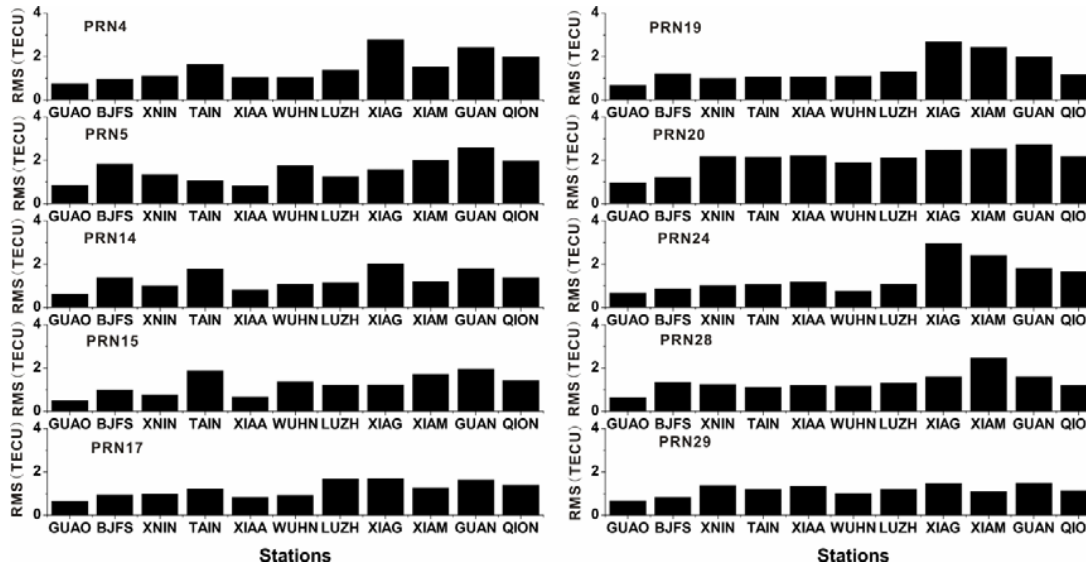
Fig. 4. RMS of instrumental biases of ten GPS satellites estimated from GPS data in 2004.